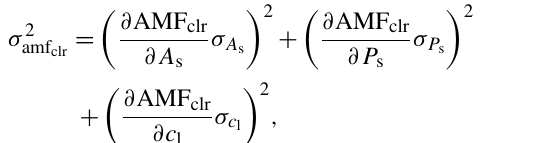
Table 4. Summary of the major sources of error in the water vapor retrieval. Error Type Typical uncertainty Instrument noise SCD Absorption cross